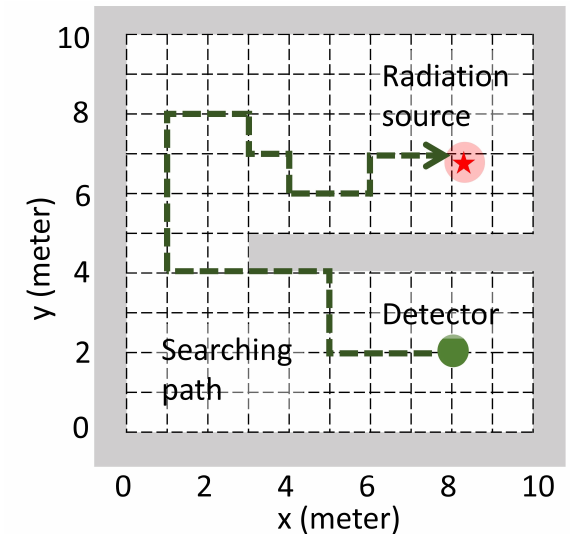
Figure 1. Illustration of the radiation detection task. The gray area denotes the searching area boundary and the walls inside the searching area. The green dashed line with arrow denotes a searching path of the